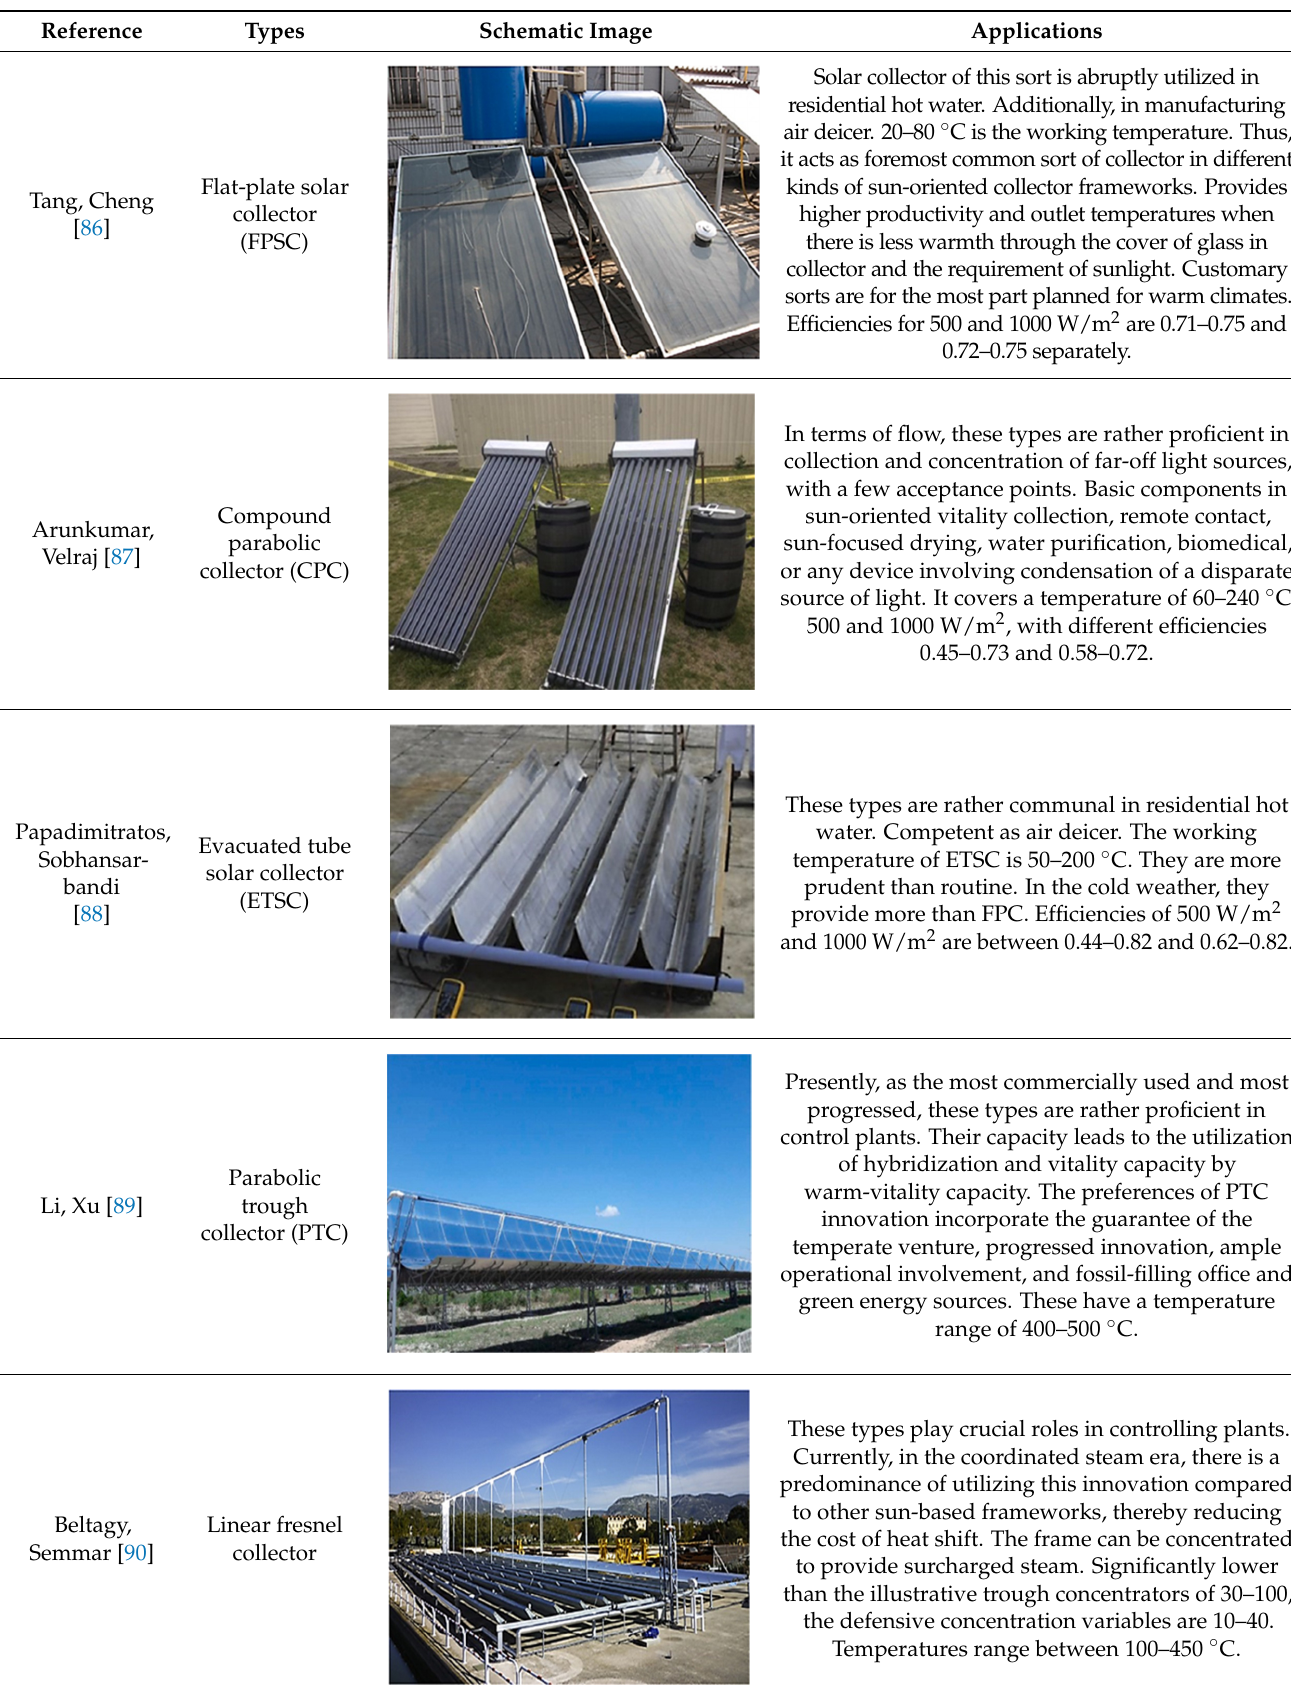
Table 1. Application of hybrid nanofluids in various solar collectors.